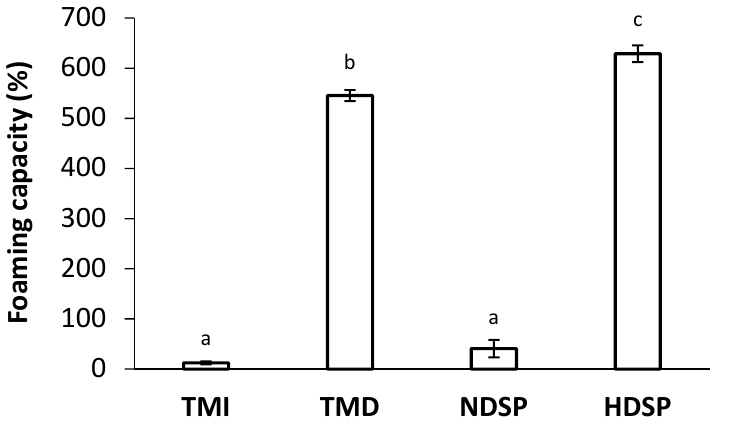
Figure 4. Foaming capacity of TMI, TMD, NDSP, and HDSP. Different letters indicate a significant difference ( p < 0.05).